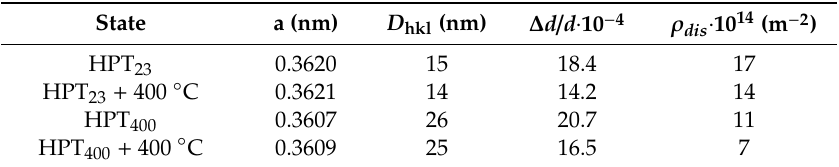
Table 1. The lattice parameter, coherent-scattering regions D hkl , and the microstrain of the crystal (cid:68) (cid:69) 1/2 ε 2 = ∆ d / d estimated from the XRD data for Fe-13Mn-1.3C steel subjected to cold and warm lattice hkl HPT and subsequent annealing at 400 ◦